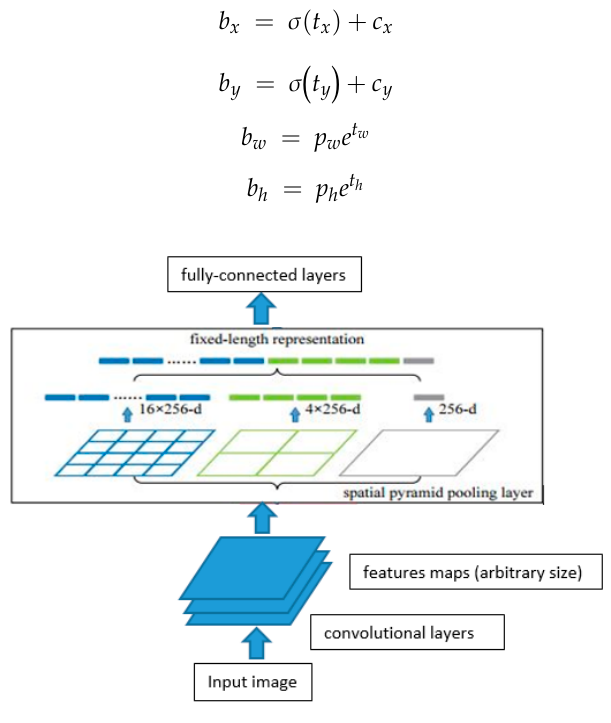
Figure 1. A network structure with a spatial pyramid pooling (SPP) layer.